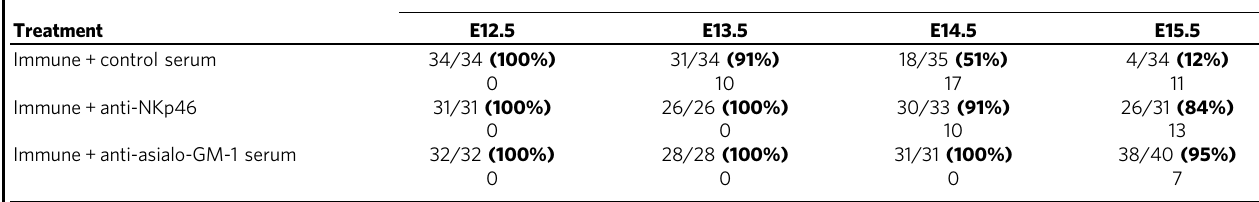
Table 2 Inhibition or depletion of uNK cell prevents fetal death at late